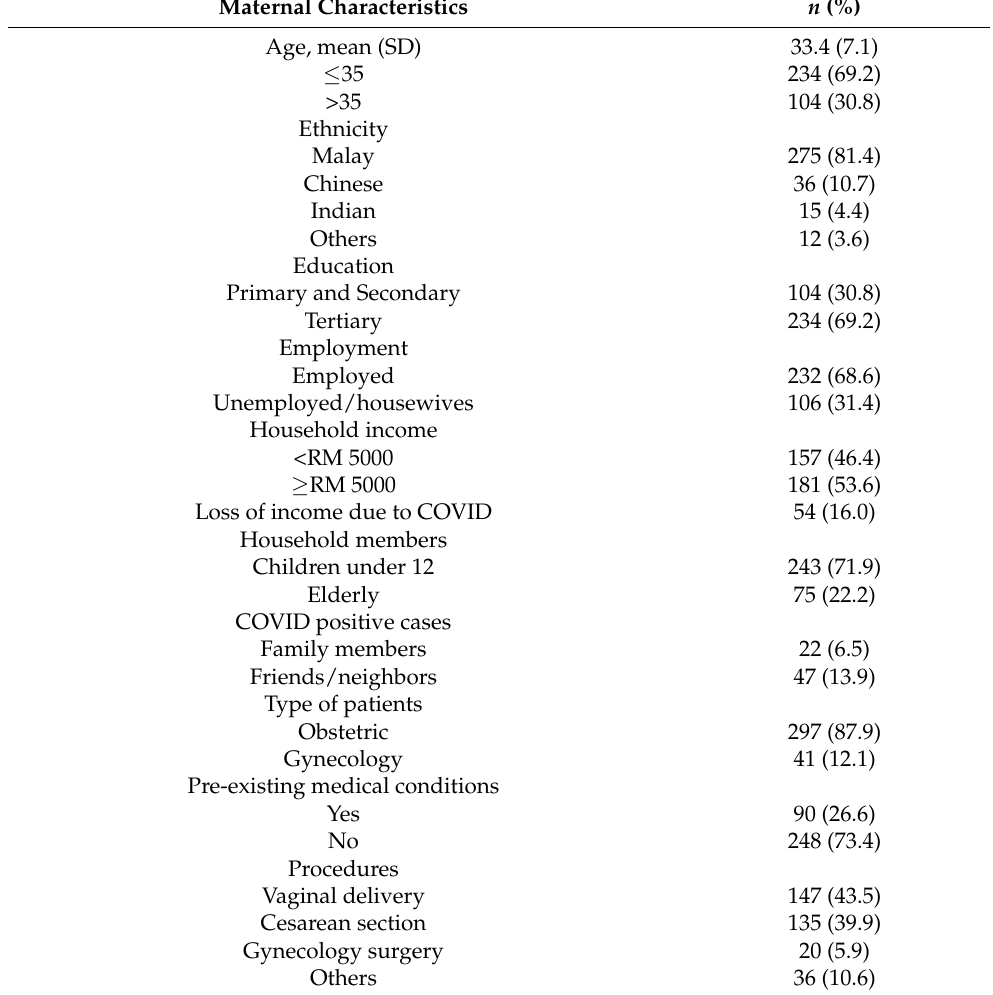
Table 1. Demographics, clinical characteristics, social